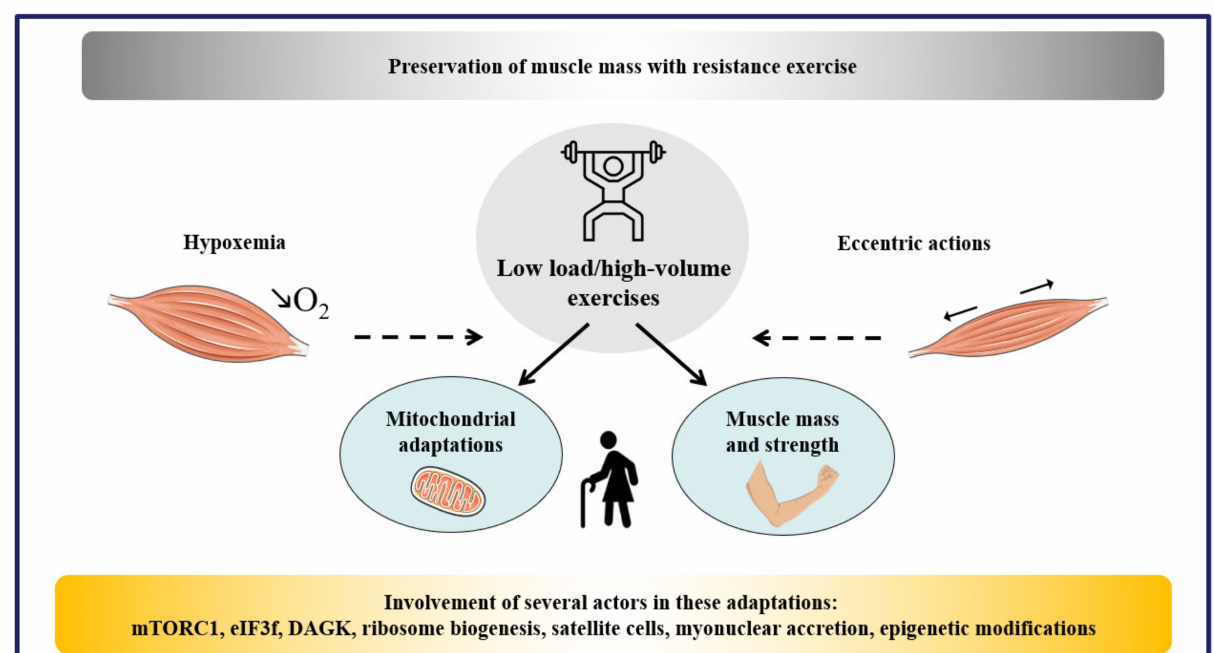
Figure 5. Resistance exercise and muscle mass preservation. Resistance training promotes hypertrophy and low- intensity/high-volume training may induce both improvements in muscle mass and strength, as well as mitochondrial adaptations in aged people. Further studies have to be encouraged to better understand the impact of resistance training combined with hypoxic stress and eccentric actions during muscle atrophy. mTORC1, mechanistic/mammalian target of rapamycin complex 1; eiF3f, eukaryotic initiation factor 3f; DAGK, diacylglycerol